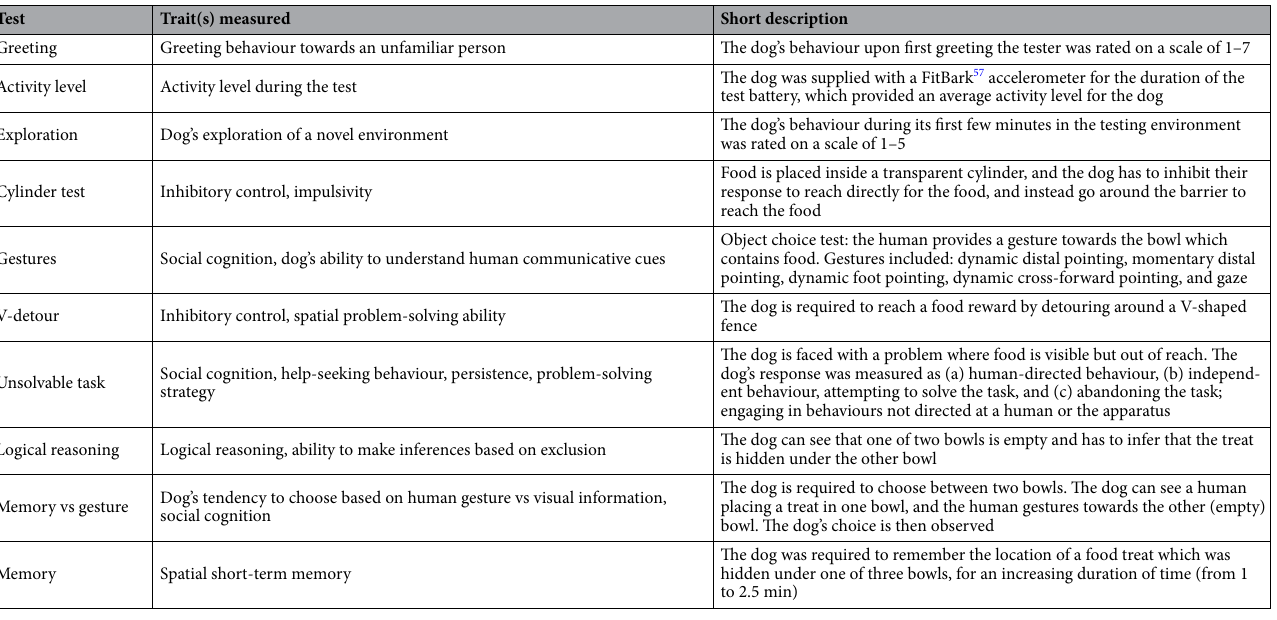
Table 2. Description of each test included in the study, in the order in which they were presented to the dog during the COGNITION test